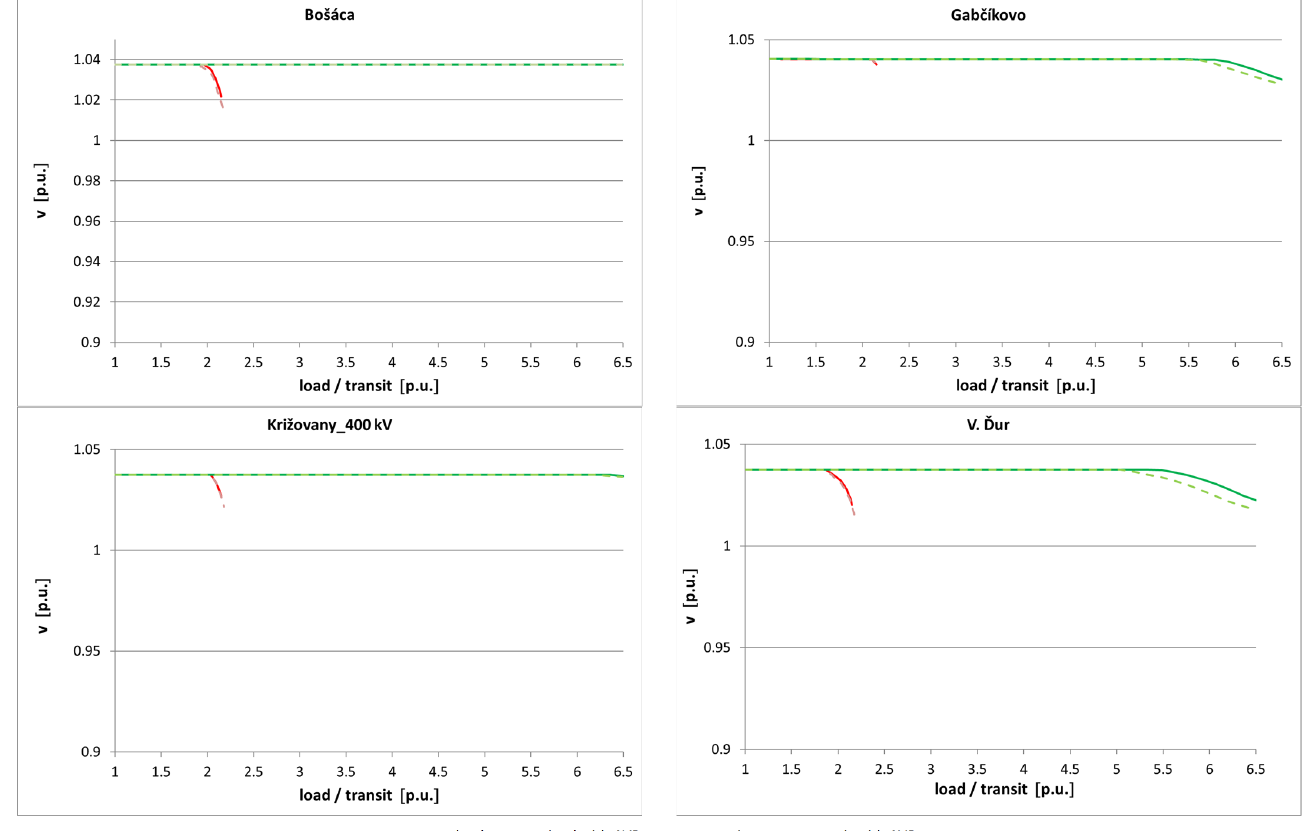
Figure 9. PV curves for the pilot nodes in the TS: summer.